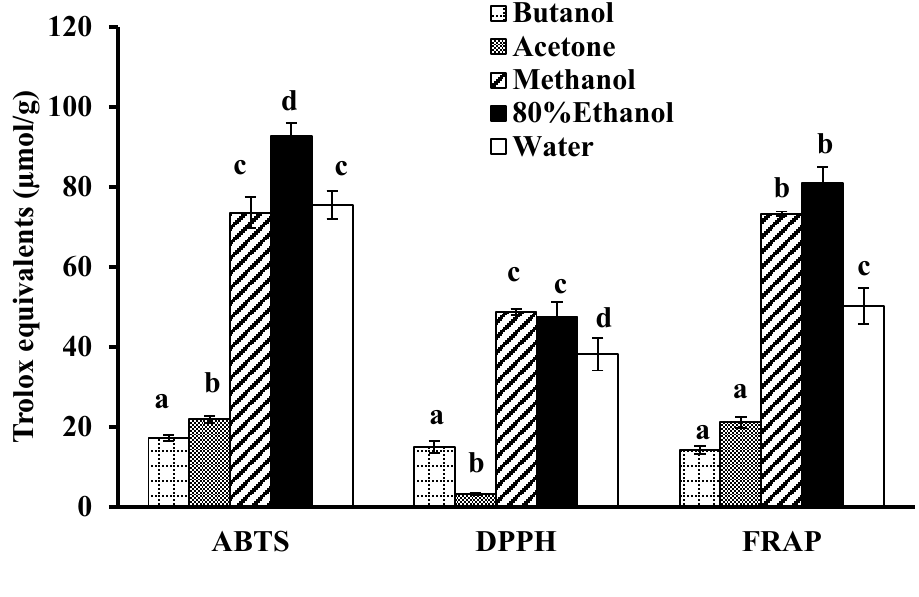
Figure 3. The 2,2′-azinobis-(3-ethylbenzothiozoline-6-sulfonic acid (ABTS), 2,2′-diphenyl-1- picrylhydrazyl (DPPH) and ferric reducing antioxidant power (FRAP) assays were used to determine the antioxidant capacity. Values are means ± standard deviations ( n = 3) and those not sharing a superscript letter are significantly different ( p < 0.05) from each